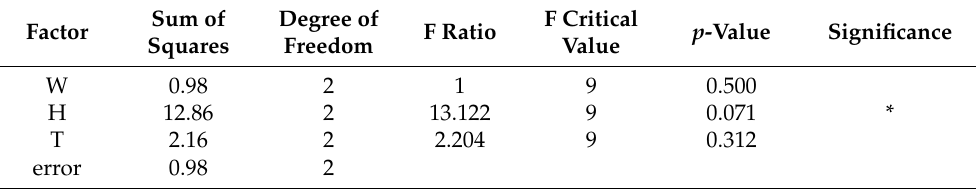
Table 12. Volume air drying shrinkage variance of impregnated heat-treated wood. F Critical Sum of Degree of p -Value F Ratio Factor Value Squares Freedom